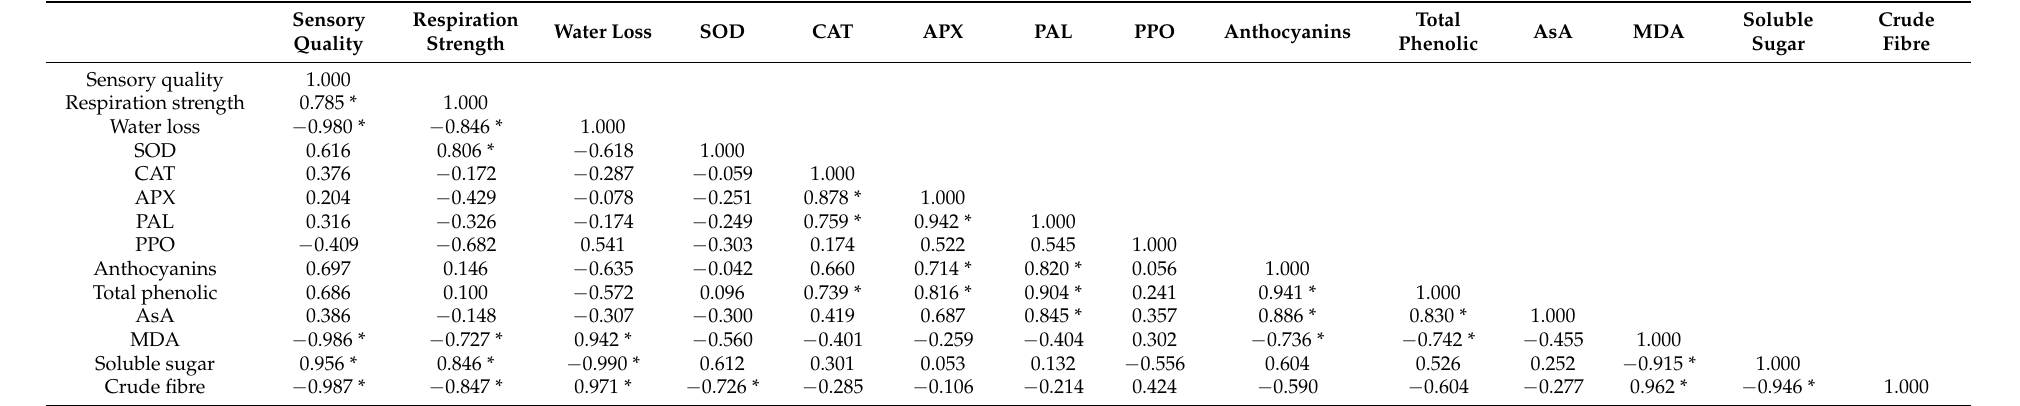
0.971 * 1.000 Note: * indicates significant correlation ( p <